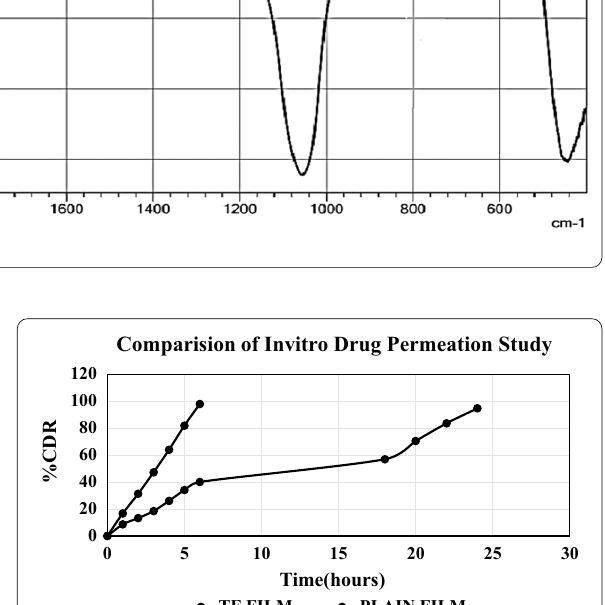
Table 8 Results of BA-loaded transferosomal film